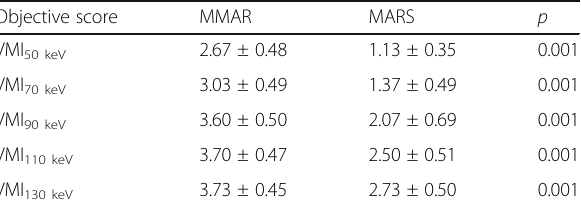
Table 2 Image scores at different energy levels ( x ± s , n = 30) Objective score